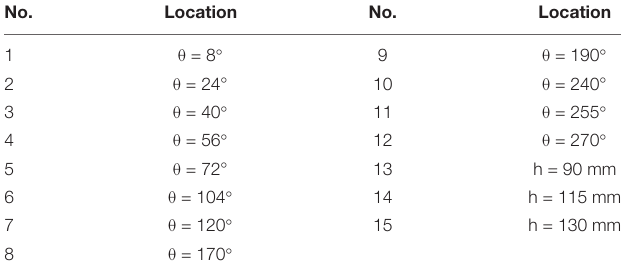
TABLE 3 | Installation position of the pressure sensor.